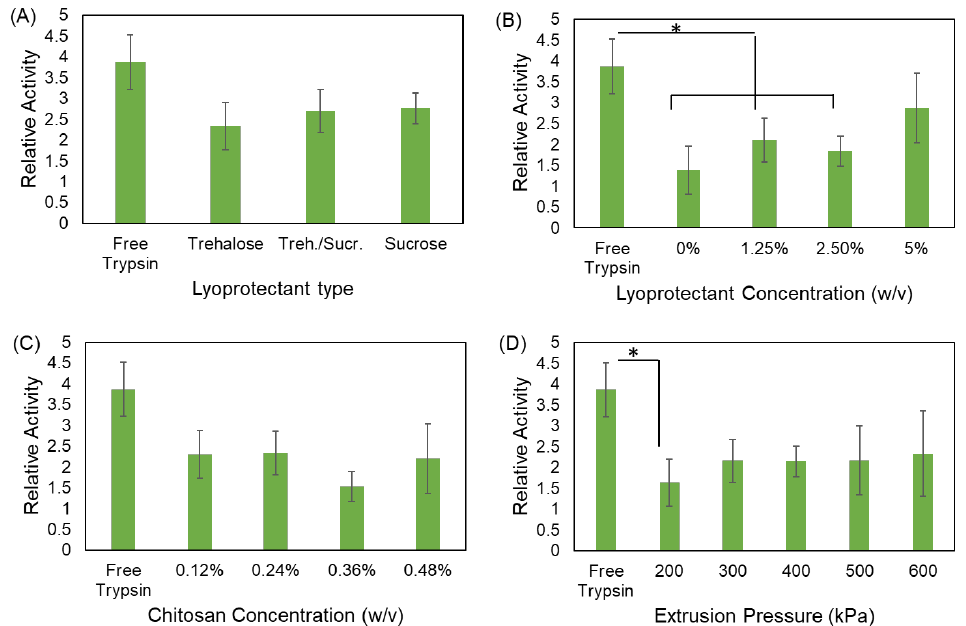
Figure 8. Effect of ( A ) lyoprotectant type, ( B ) lyoprotectant concentration, ( C ) chitosan concentra- tion, and ( D ) extrusion pressure on enzyme activity. Data points represent mean ± SD ( n = 3). * Significantly different ( p < 0.05).